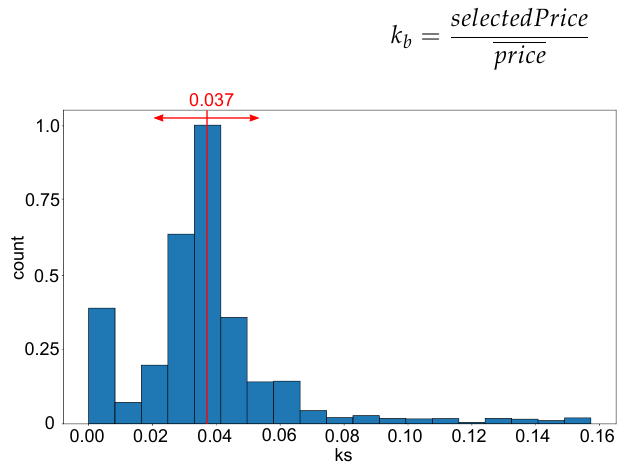
Figure 9. Strategy coefficient